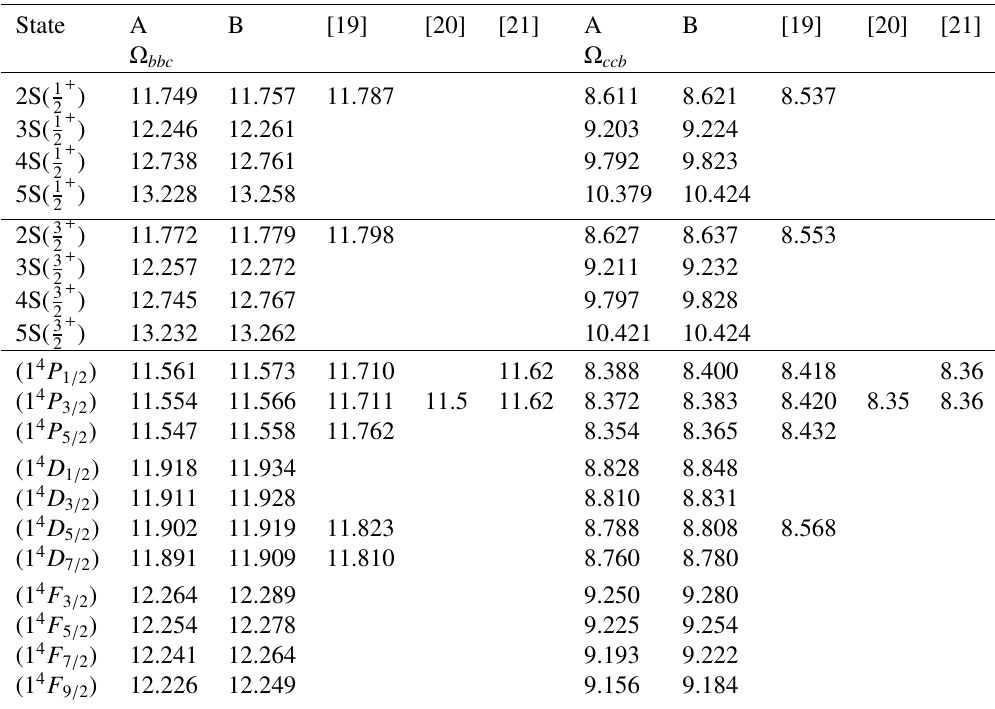
Table 2. Excited state masses of Ω bbc and Ω ccb baryons (in GeV). A and B are the masses without coreection and with first order correction to the